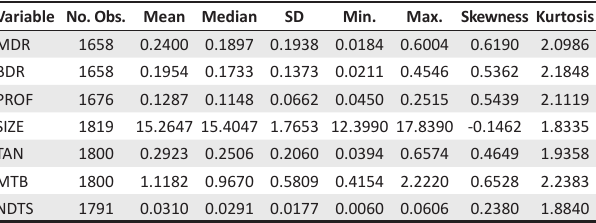
TABLE 2: Descriptive statistics for the full sample (2001–2018). Variable No. Obs. Mean Median